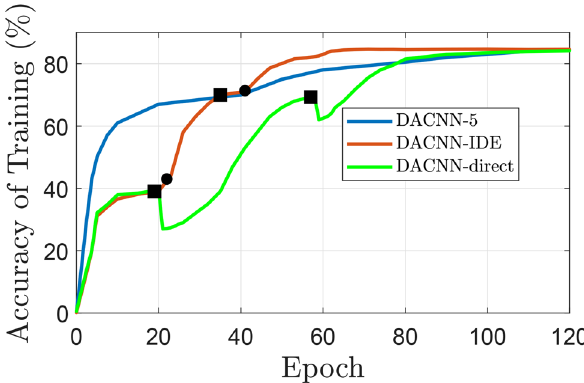
Fig. 10 Effect of IDI module in the learning curve of DACNN on Montalbano V2. The squares show the epochs when a new deep layer is initialized, and the circles indicate when the IDI module finishes the pretraining of that layer and adds it to the main loop of DACNN